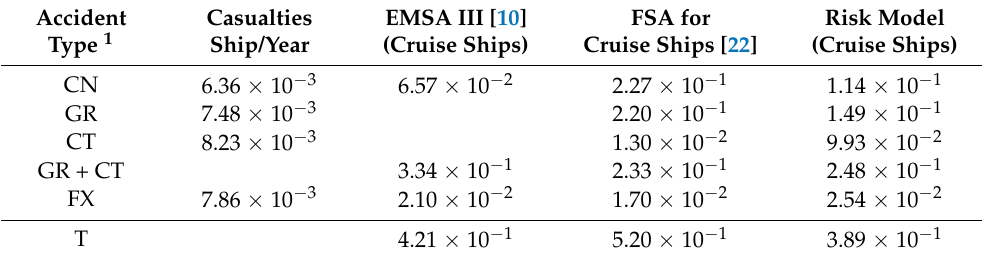
Table 5. Risk model results for the baseline scenario in terms of PLL per ship/year for all accidents of interest, including the frequency of casualties and results from previous studies.